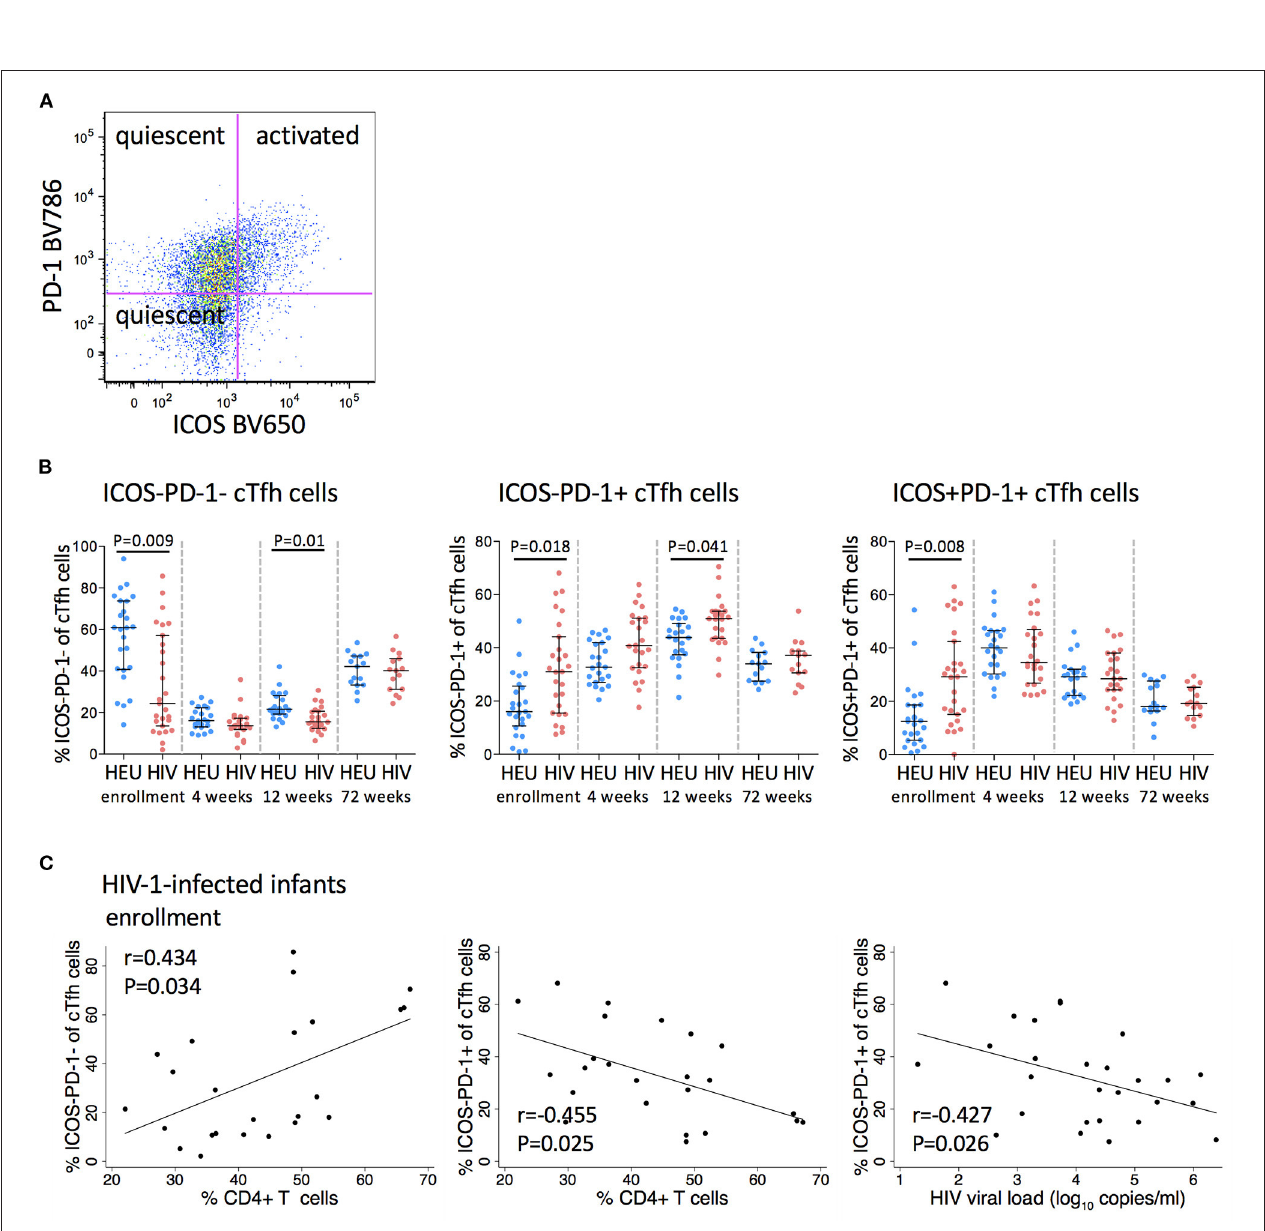
FIGURE 2 | Tfh17 (green), and the other Tfh subsets (purple) within total cTfh cells. Areas represent the medians of frequencies. (C) Frequencies of Tfh1, Tfh2, and Tfh17 subsets of total cTfh cells in HEU and HIV-1-infected infants at enrollment, 4, 12, and 72 weeks. Each symbol represents an infant. Horizontal lines and error bars represent the median, 25 and 75th percentiles. Significant P -values are shown. (D) Correlations between frequencies of Tfh1, Tfh2, and Tfh17 cells with % CD4 + T cells at enrollment and 72 weeks in HIV-1-infected infants. Lines are calculated using simple linear regression. Spearman rho (r) values and P -values are shown.